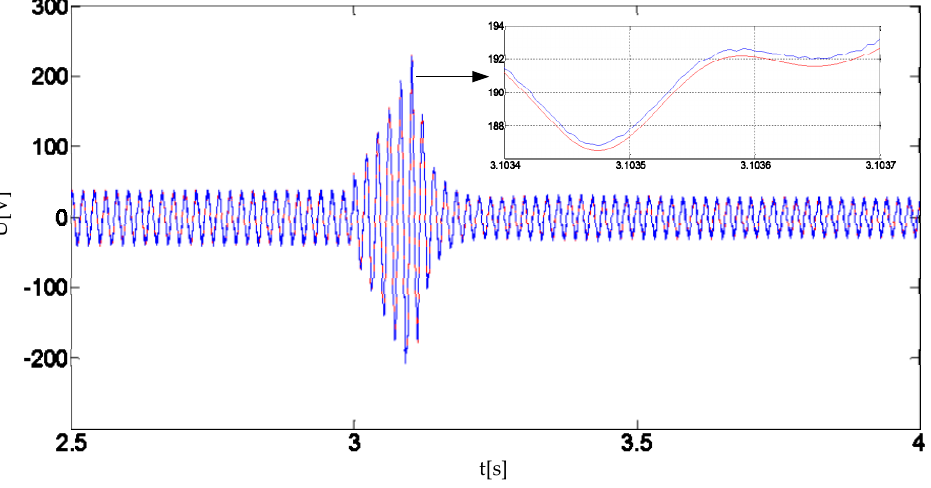
Figure 10. The A phase output current waveform of node 30.